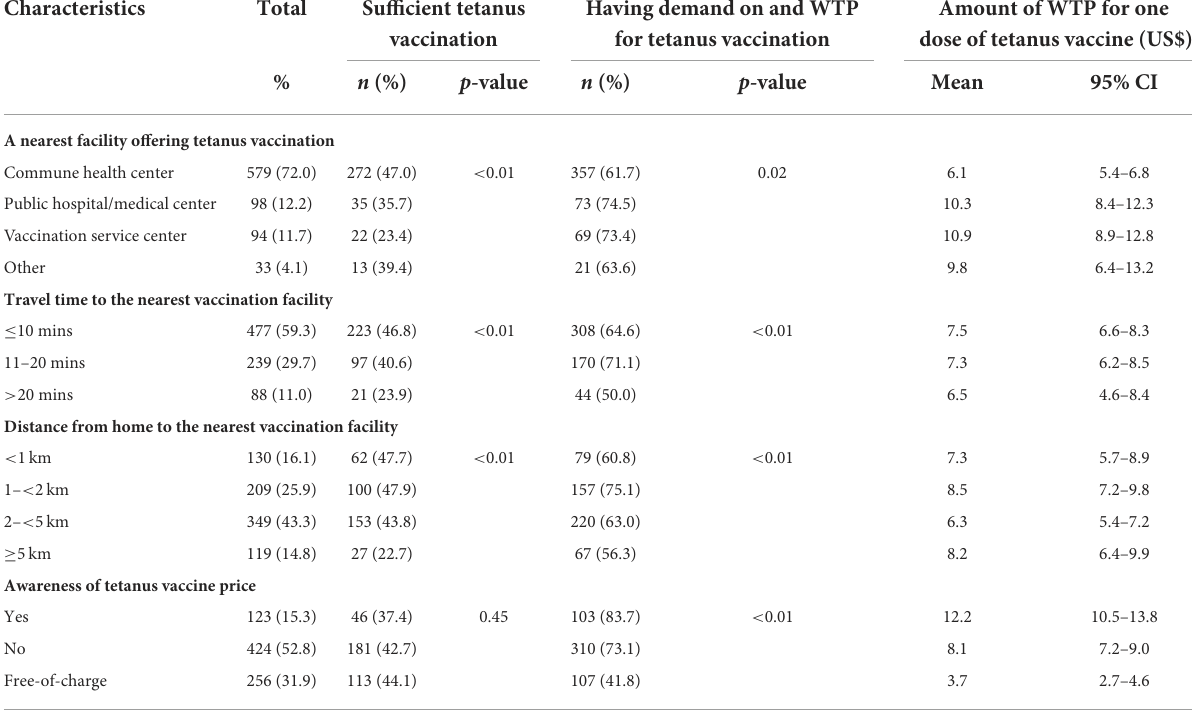
TABLE 3 Tetanus vaccination uptake, demand, and WTP by accessibility to tetanus